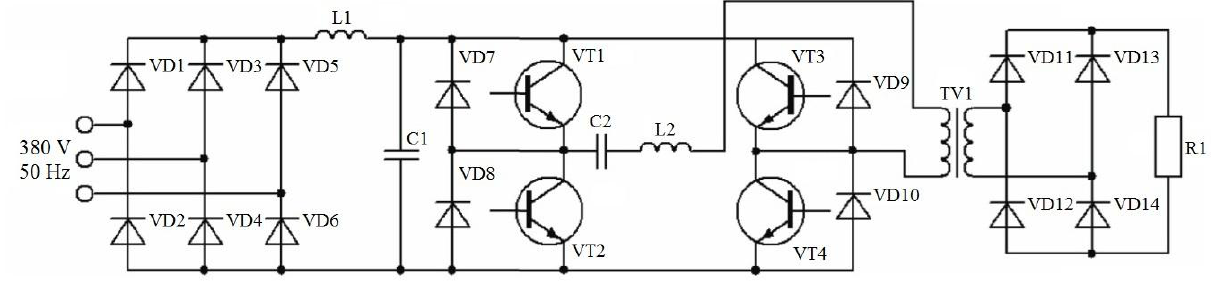
Figure 28. Electric diagram of a generator used for sintering experiments. The generator has a transistor-based bridge